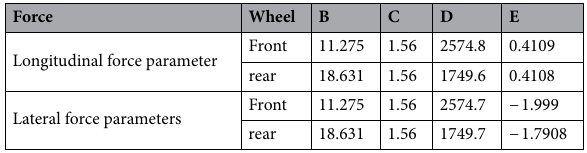
Table 3. Tire force parameters under low adhesion road.